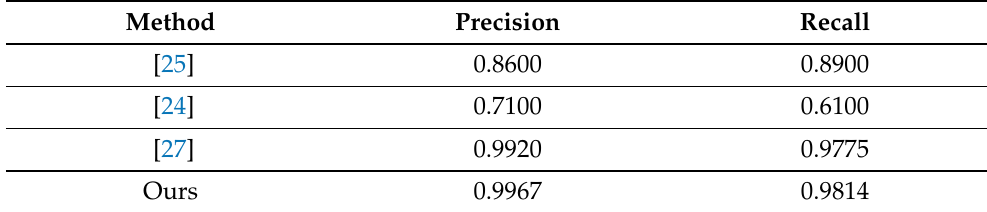
Table 4. Comparison of precision and recall of the proposed method with the state-of-the-art. Method